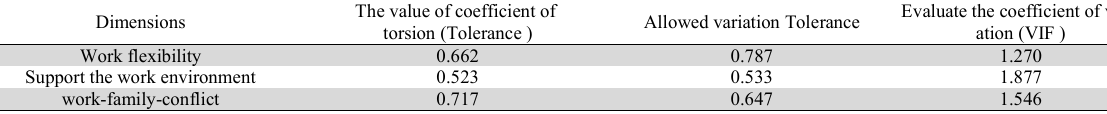
The results of testing the hypotheses of the survey